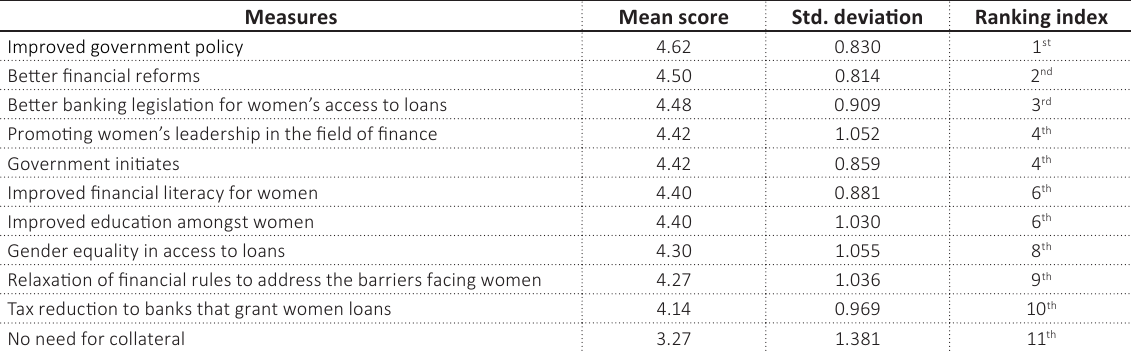
Table 5. Measures that will enhance women’s access to building